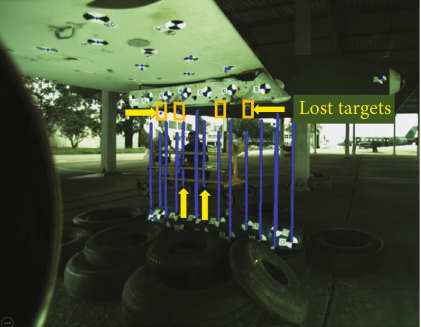
Figure 30: Store trajectory measured by the front